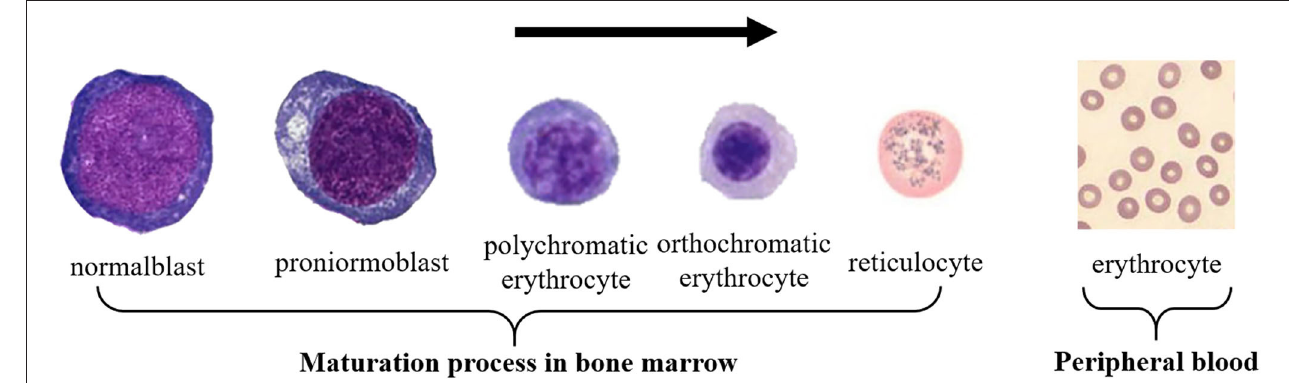
FIGURE 1 | Red blood cell maturation process.